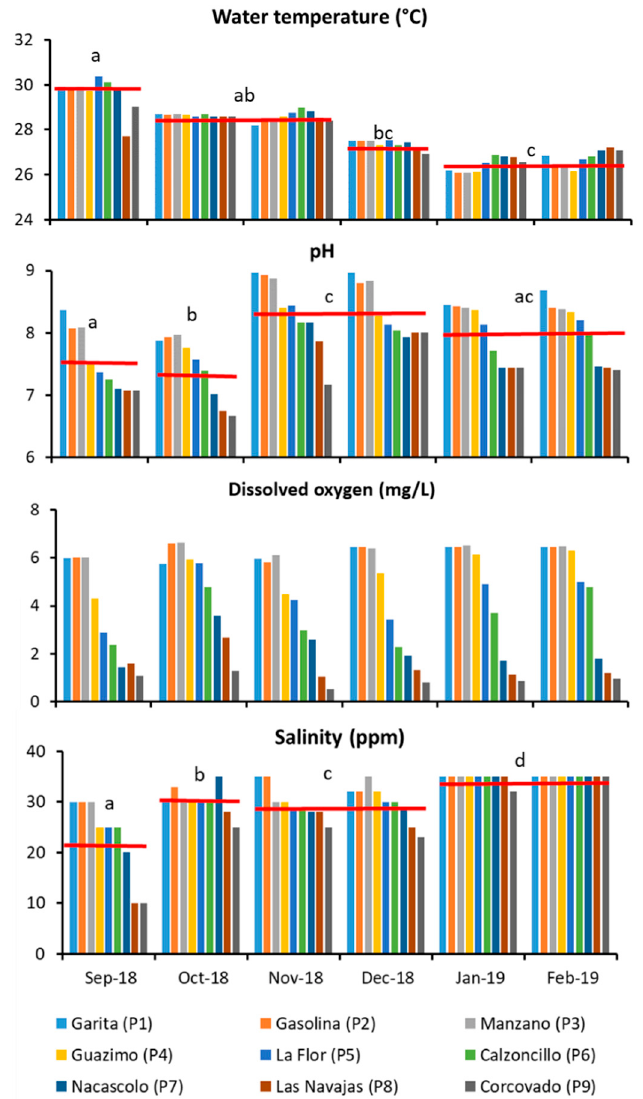
Figure 7. Physicochemical variables measured in the nine sites of the Estero Salinas Grandes. Red lines show the mean of each different group based on ANOVA results (Table S2; Supplementary material). The lower-case letters indicate significant differences in pairwise comparisons. Significant values when p < 0.001.